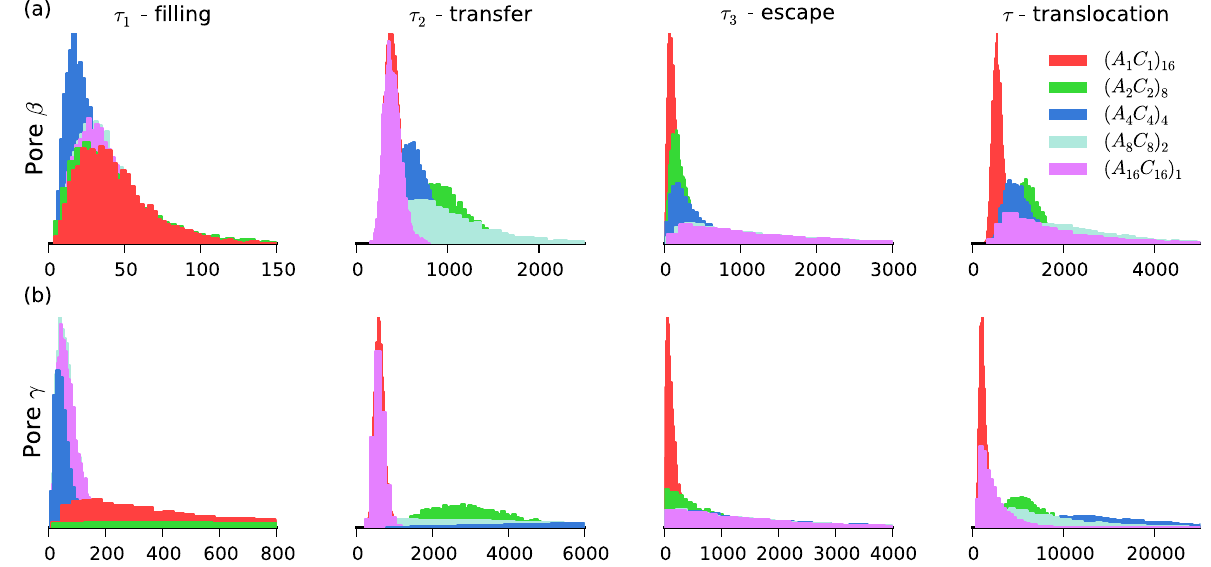
FIG. 3. Translocation time statistics for heteropolymers. Comparison of filling, transfer, escape, and translocation time distributions for Pores (cid:3) (a) and (cid:4) (b) and five different sequences of the heteropolymer. The distributions correspond to F ¼ 1 : 0 for Pore (cid:3) , and F ¼ 0 : 5 for Pore (cid:4) ,